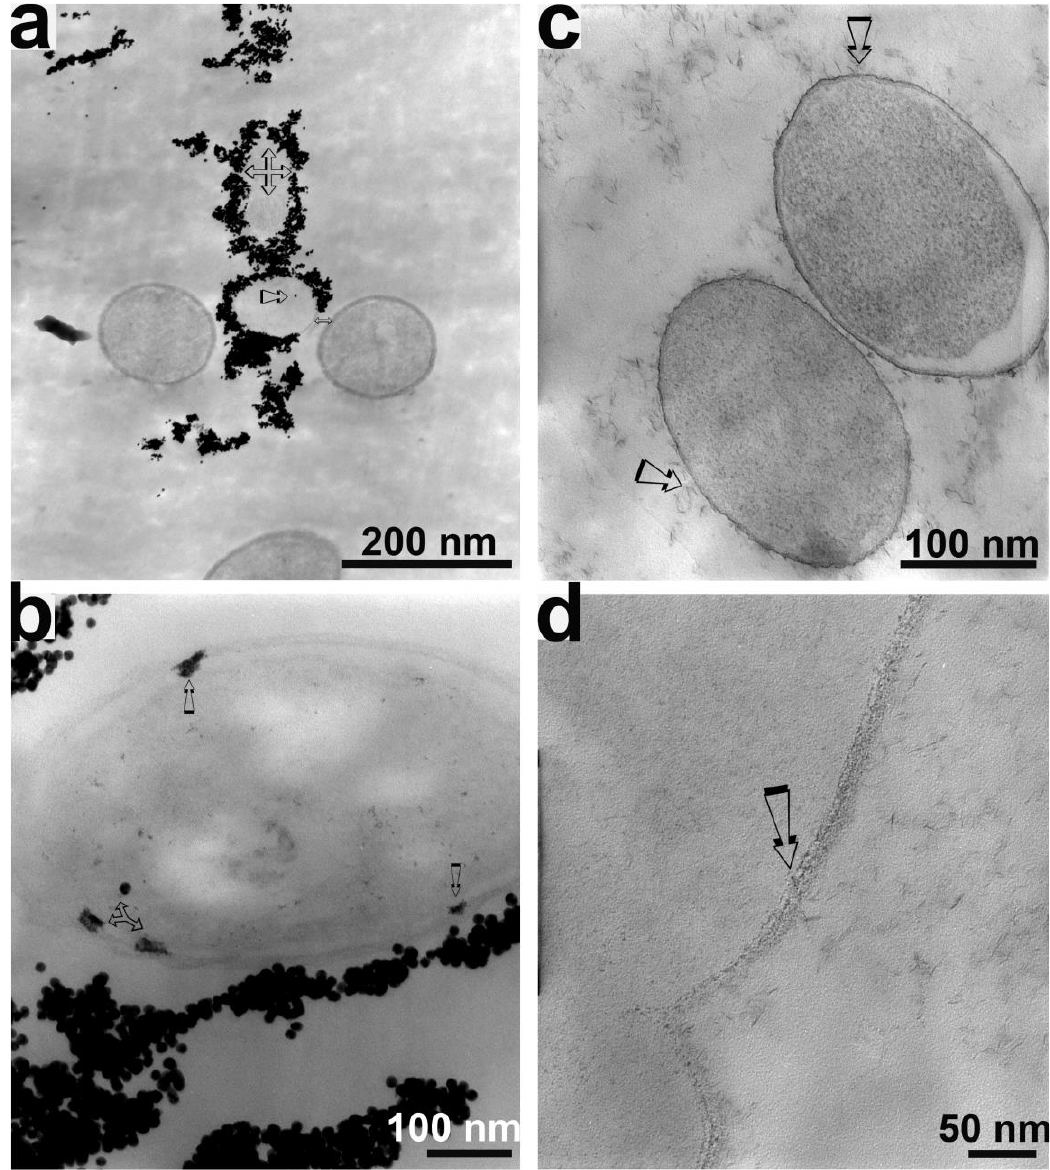
Figure 3. TEM images of nanoparticles and E. coli showing the interaction of the bacteria with the nanoparticles. ( a , b ) Gold nanoparticles with E. coli , ( c , d ) laponite nanoparticles with E. coli . Arrows in the figure represent the cell membrane of E. coli cells and damage of nanoparticles to cell membrane of E. coli cells. Arrow represent different morphology of nanoparticles.